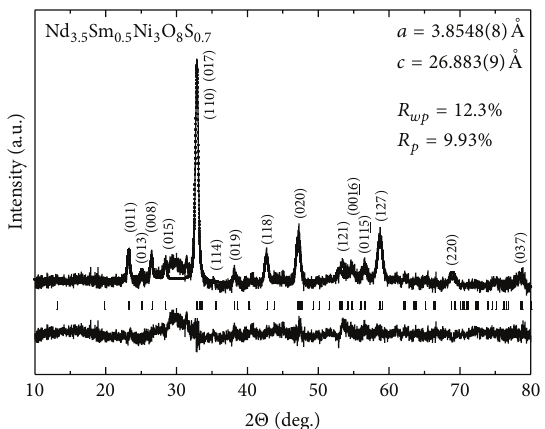
Figure 5: Temperature dependence of 𝜌 for sulfur-deintercalated